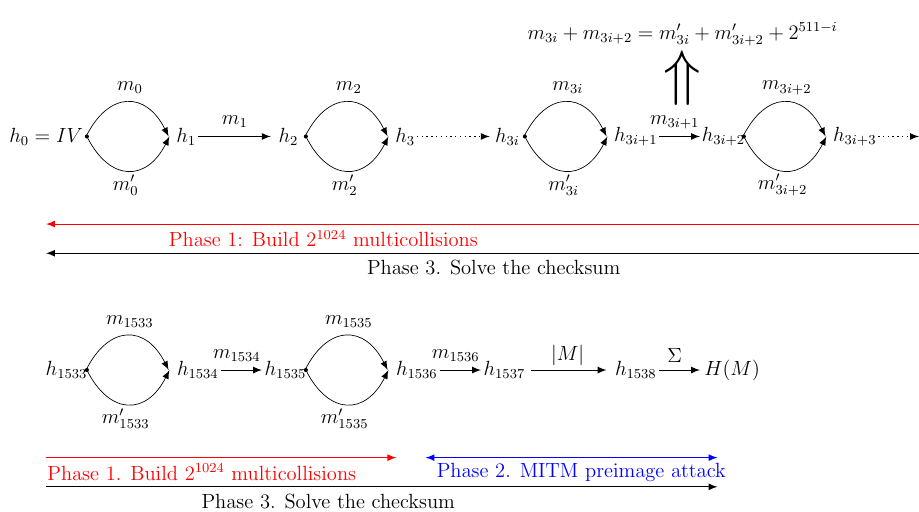
Figure 8: Framework of preimage attack on